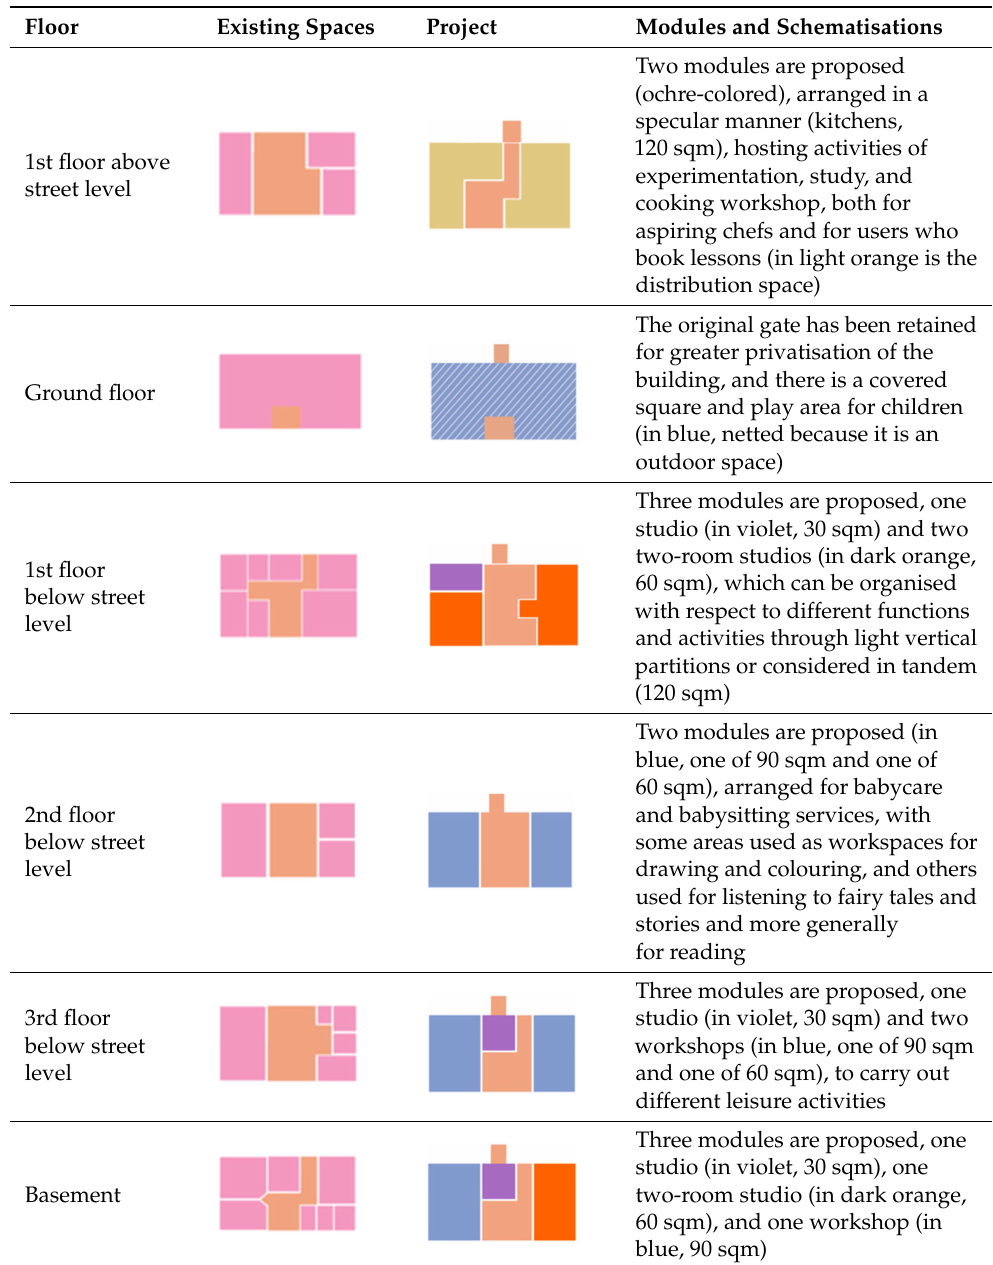
Table 2. Definition of the modules and schematisation for the